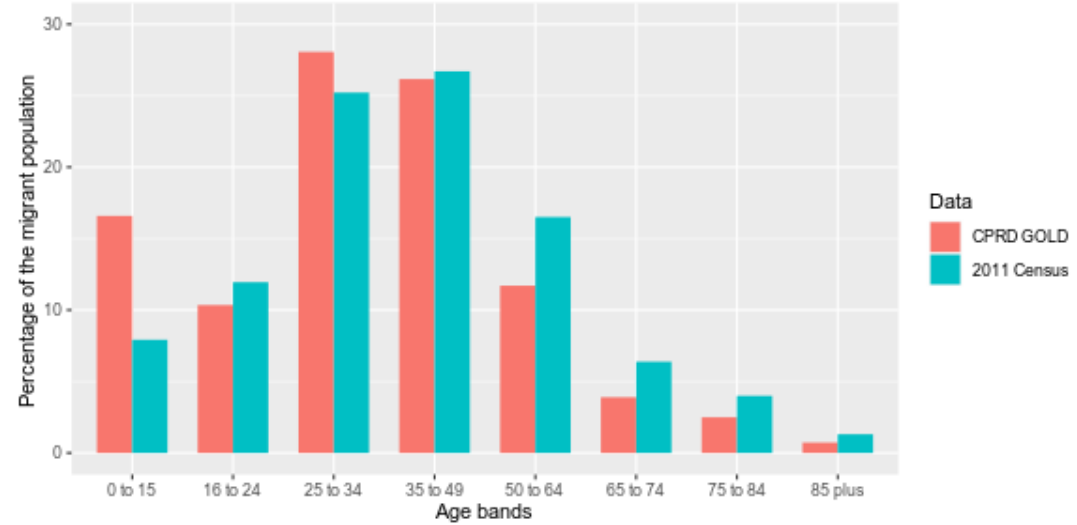
Figure 4. Percentage age breakdown of CPRD (2011) and ONS migrant population at the time of the 2011 census.